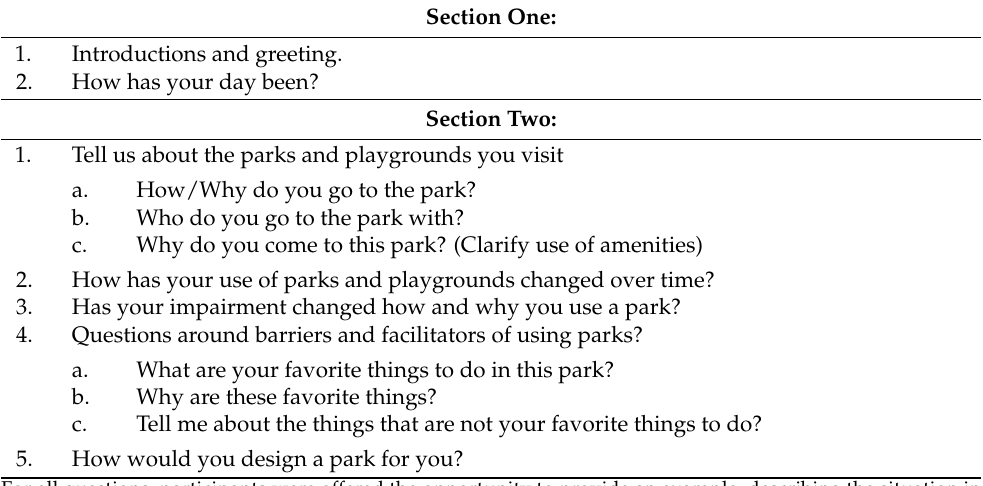
Table 1. Semi-structured focus group and interview guide: Key areas for